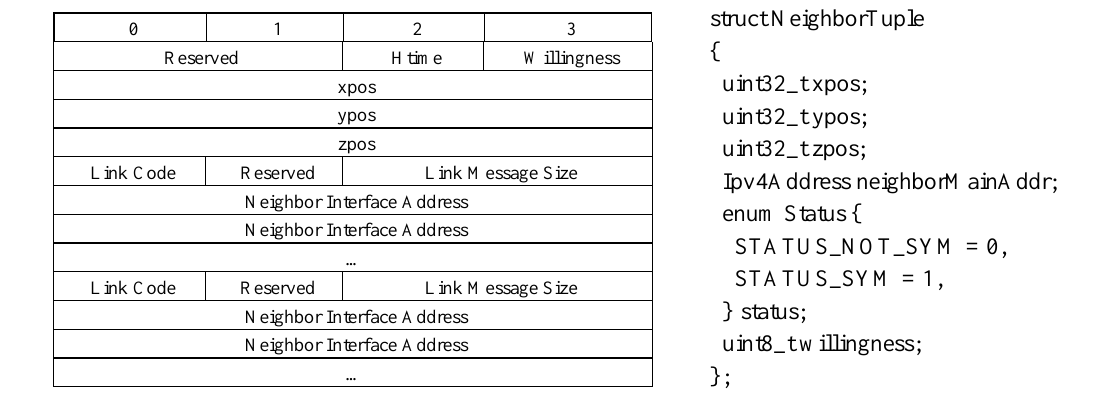
Table 1. The HELLO message format after revision.